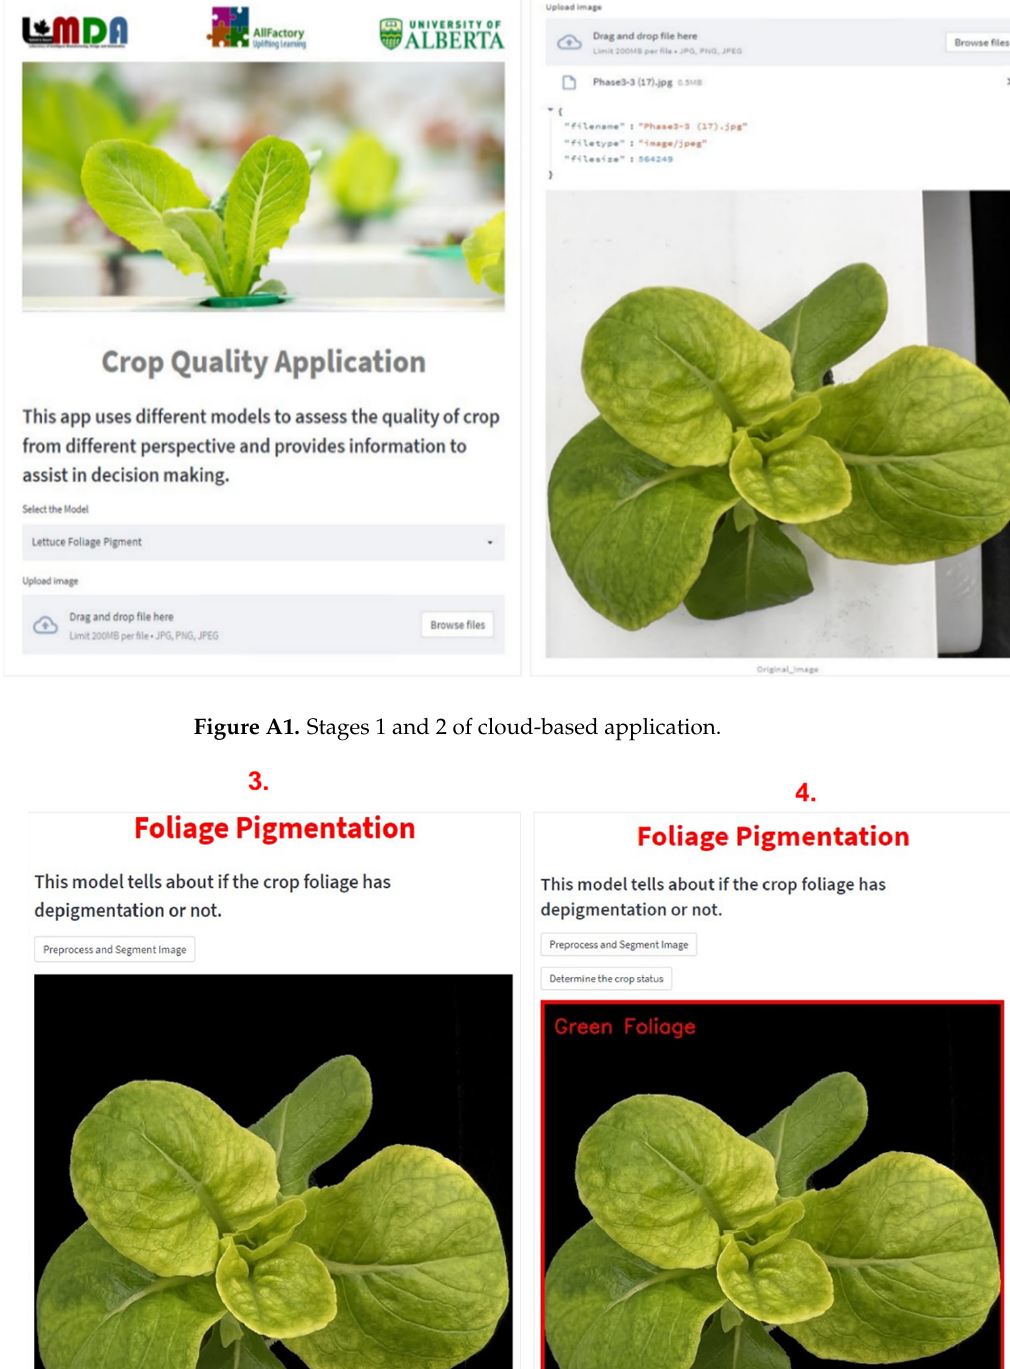
Figure A1. Stages 1 and 2 of cloud-based application.